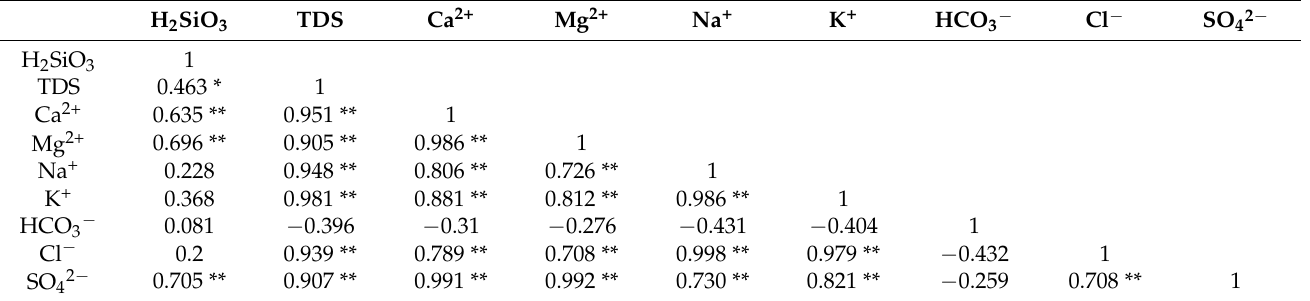
Table 4. Correlation coefficient matrix of hydrochemical parameters of the groundwater in the study